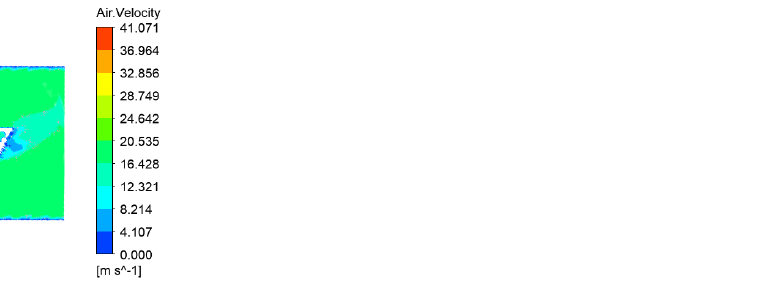
Figure 35. Cloud map of velocity distribution in the plane with 30 ◦ wind elevation